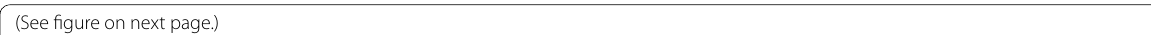
400/> 400 patients ≤